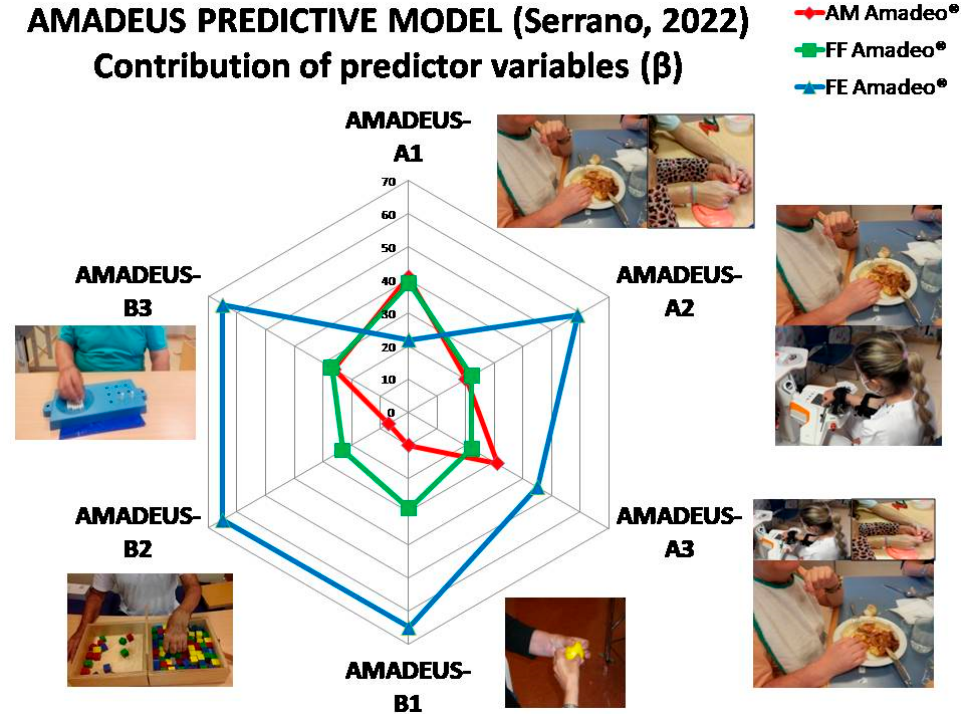
Figure 6. Submodels composing the AMADEUS Global Predictive Model. Contribution of pre- Figure 5. Submodels composing the AMADEUS Global Predictive Model. Contribution of predictor dictor and criteria variables, with regression graphics. and criteria variables, with regression